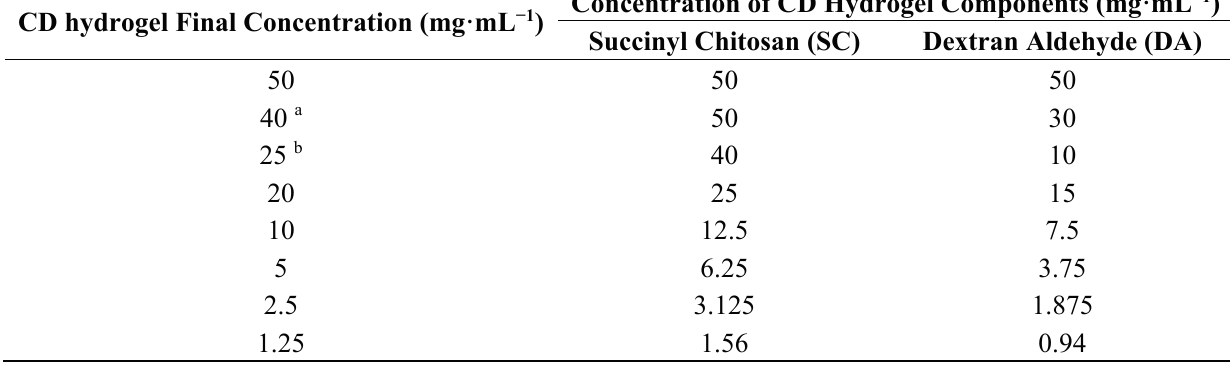
Table 3. Table of the concentrations used in the formation of the CD hydrogel. CD hydrogel final concentration is calculated to reflect a dilution, as the hydrogel is formed using a 1:1 mixture of the concentration of SC and DA.